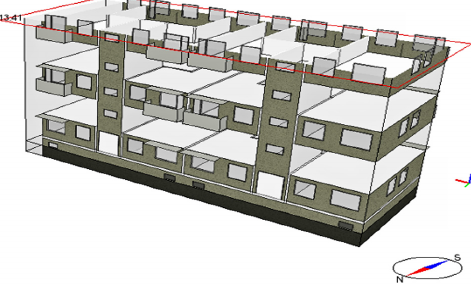
Fig. 3. Simulation model in IDA-ICE (2014) of the studied building